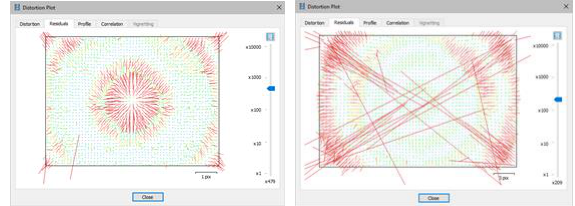
Figure 10. Image residuals after bundle adjustment